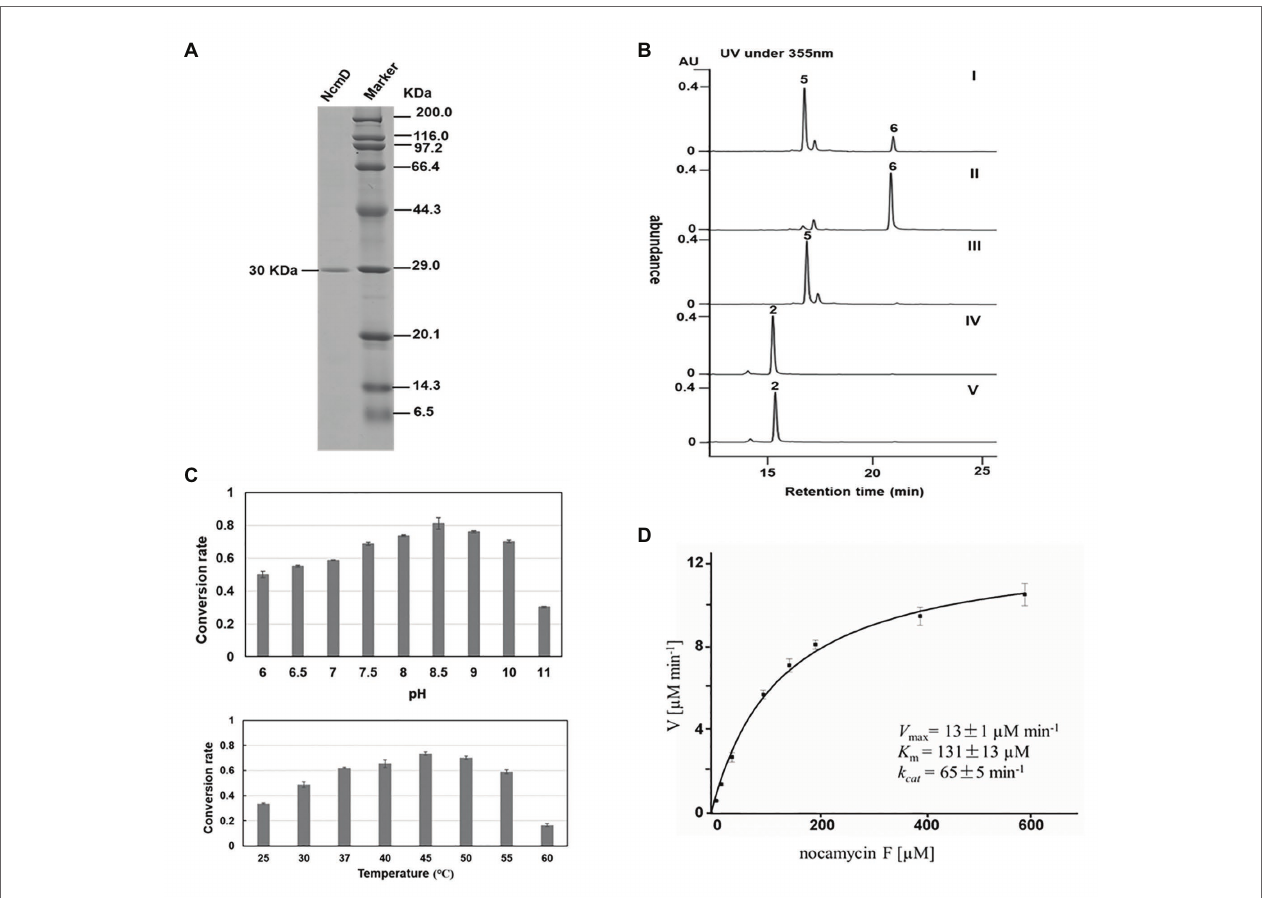
FIGURE 5 | Biochemical characterization of NcmD. (A) Analysis of purified recombinant NcmD protein by SDS-PAGE gel. Lane 1 is the recombinant NcmD, lane 2 is protein standard. (B) HPLC analysis of NcmD with nocamycin F (5) and nocamycin II (2). I: an assay of NcmD with 5 and cofactor NADP + . II:an assay of NcmD with 5 and cofactor NAD + . III: an assay of boiled NcmD with 5 and cofactor NAD + . IV: an assay of NcmD with 2 and cofactor NAD + . V: an assay of boiled NcmD with 2 and cofactor NAD + . (C) Biochemical properties of NcmD. Upper: effects of pH on NcmD activity. Down: effects of temperature on NcmD activity. (D) Kinetic analysis of